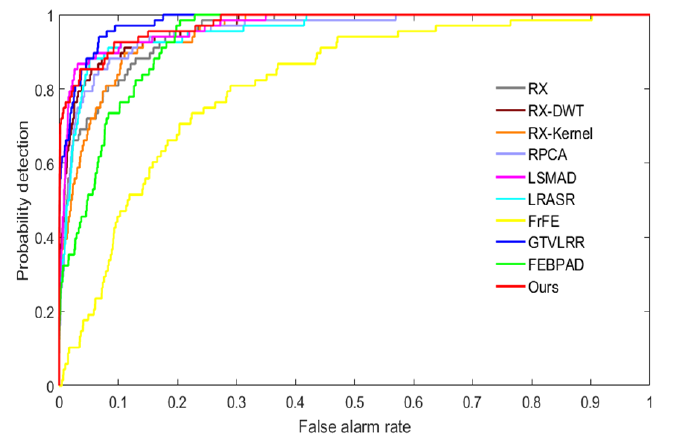
Figure 12. ROC curves of anomaly detectors on the Pavia Centre dataset.